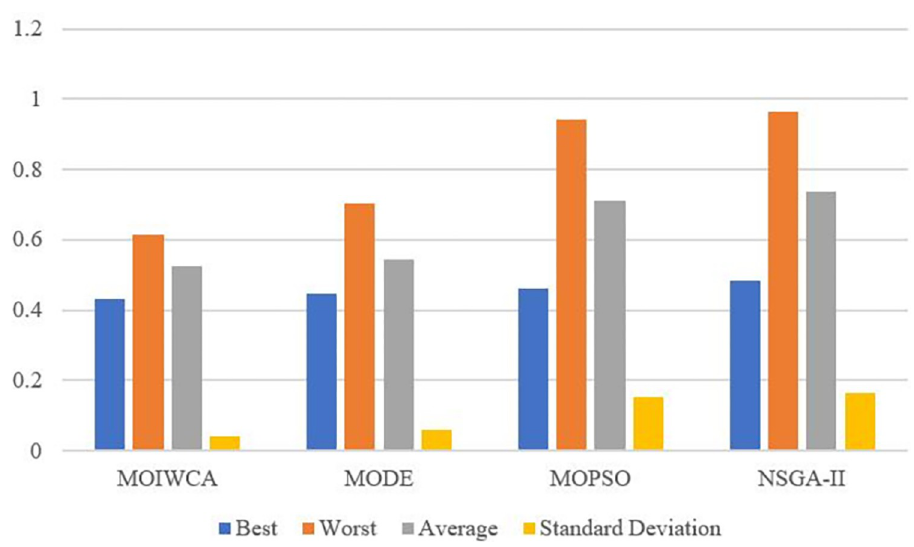
Fig 16. Comparison of Spacing metric for different algorithm.